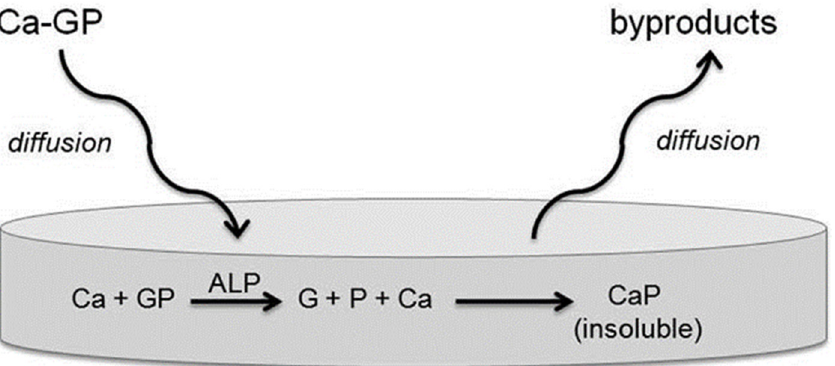
Figure 10. Basic principle of mineralization by entrapped ALP. Calcium glycerophosphate (Ca-GP) diffuses into hydrogels with incorporated ALP. Inside the hydrogel, glycerophosphate (GP) is cleaved to phosphate (P) by ALP, which reacts with Ca 2+ ions to form insoluble CaP. Reproduced with permission from [102]. Copyright 2012 Wiley.